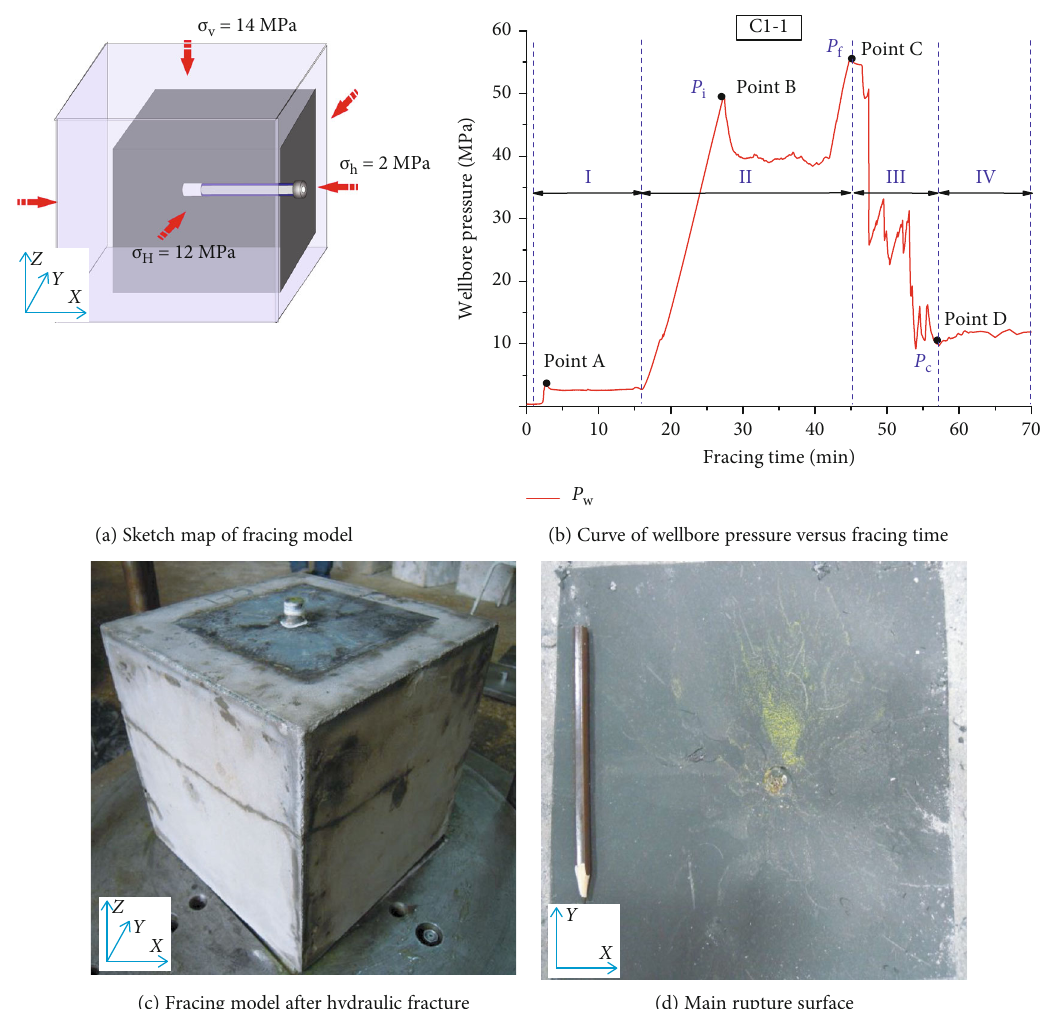
Figure 11: Results of volumetric fracing test for specimen